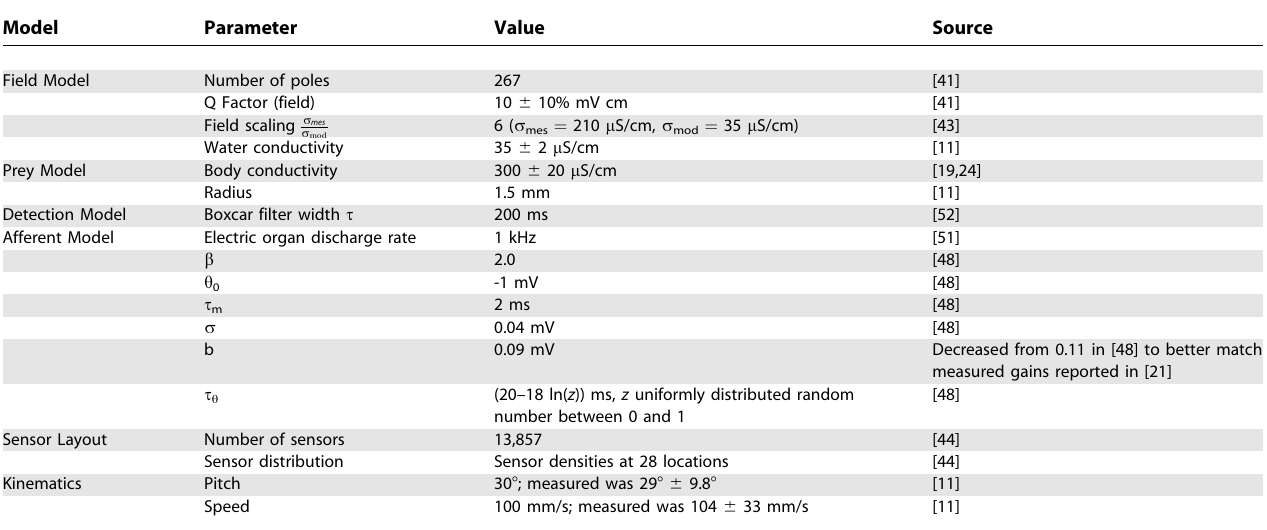
Table 1. Model Parameters